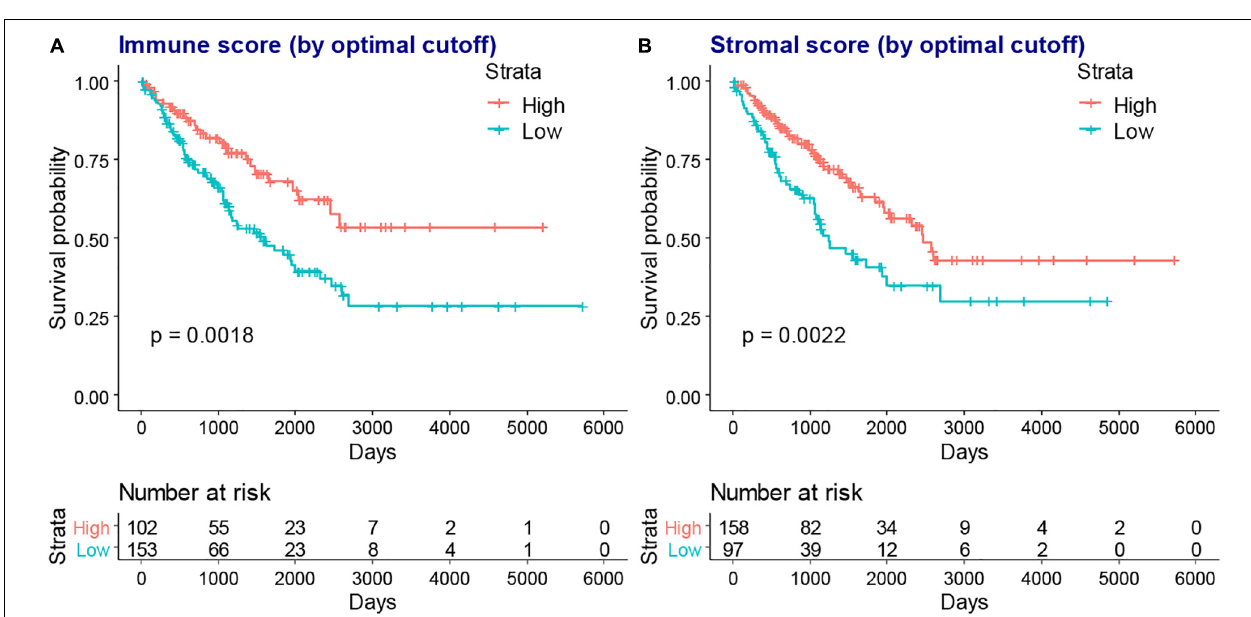
FIGURE 3 | The KM plot of immune scores or stromal scores and the overall survival of patients with SARC. The lower immune scores (A) and stromal scores (B) indicated worse overall survival in the KM plot model which stratified by optimal cutoff value.